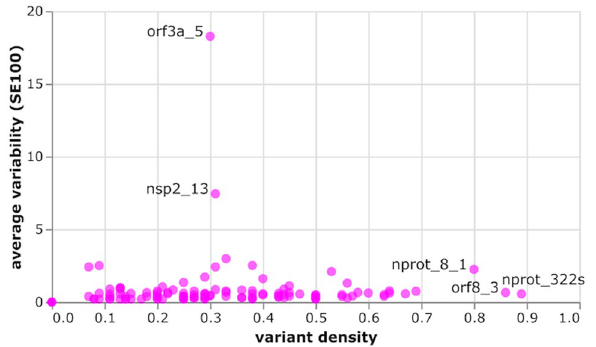
Figure 4. Amino acid variation in predicted epitopes, as average variability (SE100 = 100*Shannon entropy over epitope length) vs variant density. Epitopes with variants detected in over 80% of residues or variability above 5 are labelled. The high SE100 of orf3a_5 and nsp2_13 are due to single conserved